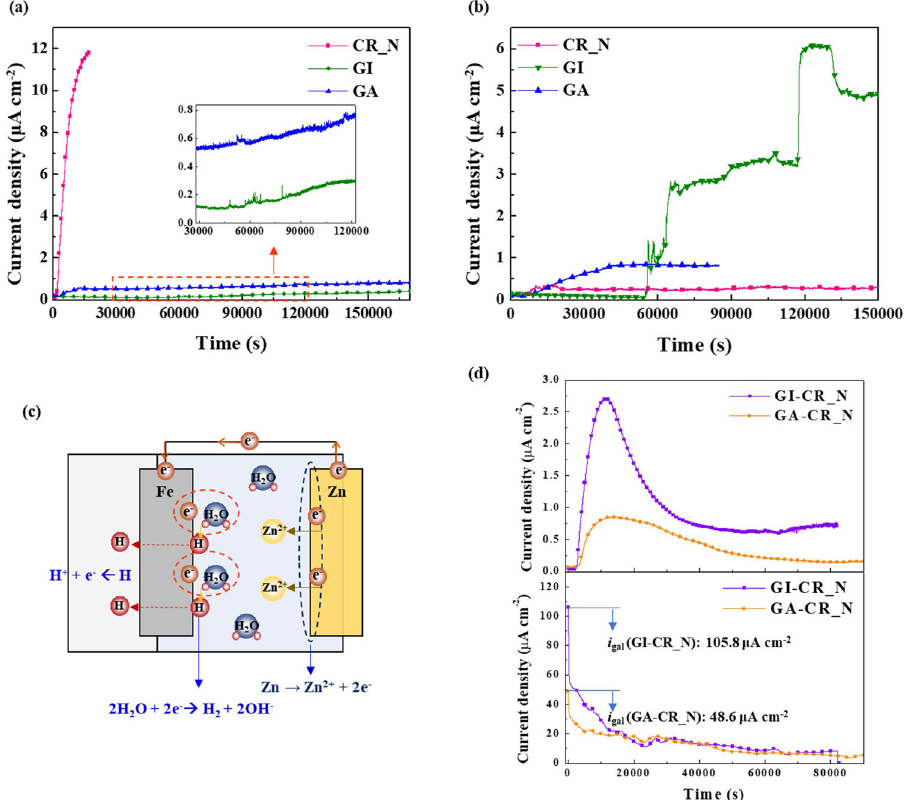
Fig. 8 Electrochemical and simple corrosion induced hydrogen permeation behaviors. a , b Electrochemical permeation curves obtained using the typical permeation apparatus with and without the application of cathodic current in the charging side, respectively. c Brief sketch showing the principle of the hydrogen permeation measurements using the modi fi ed permeation apparatus with the galvanic corrosion cell in the charging side. d Hydrogen permeation current densities and galvanic current densities measured in detection side and galvanic corrosion side, respectively, of the modi fi ed permeation